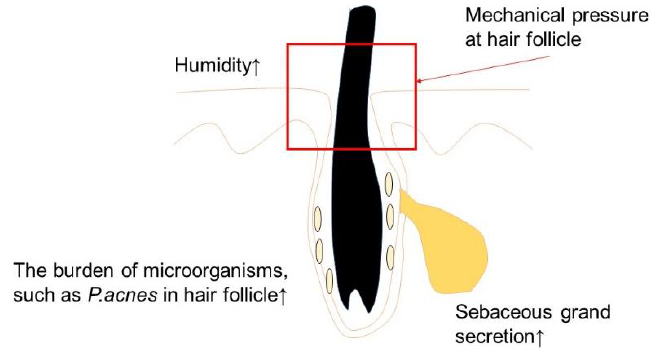
Figure 3. The pathogenesis of acne vulgaris.